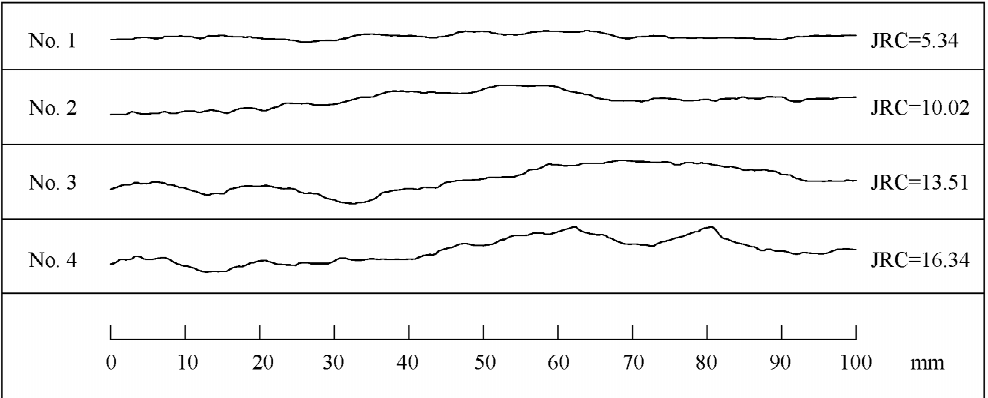
Figure 1. Standard profiles of fracture surfaces with different joint roughness coefficients (JRCs).